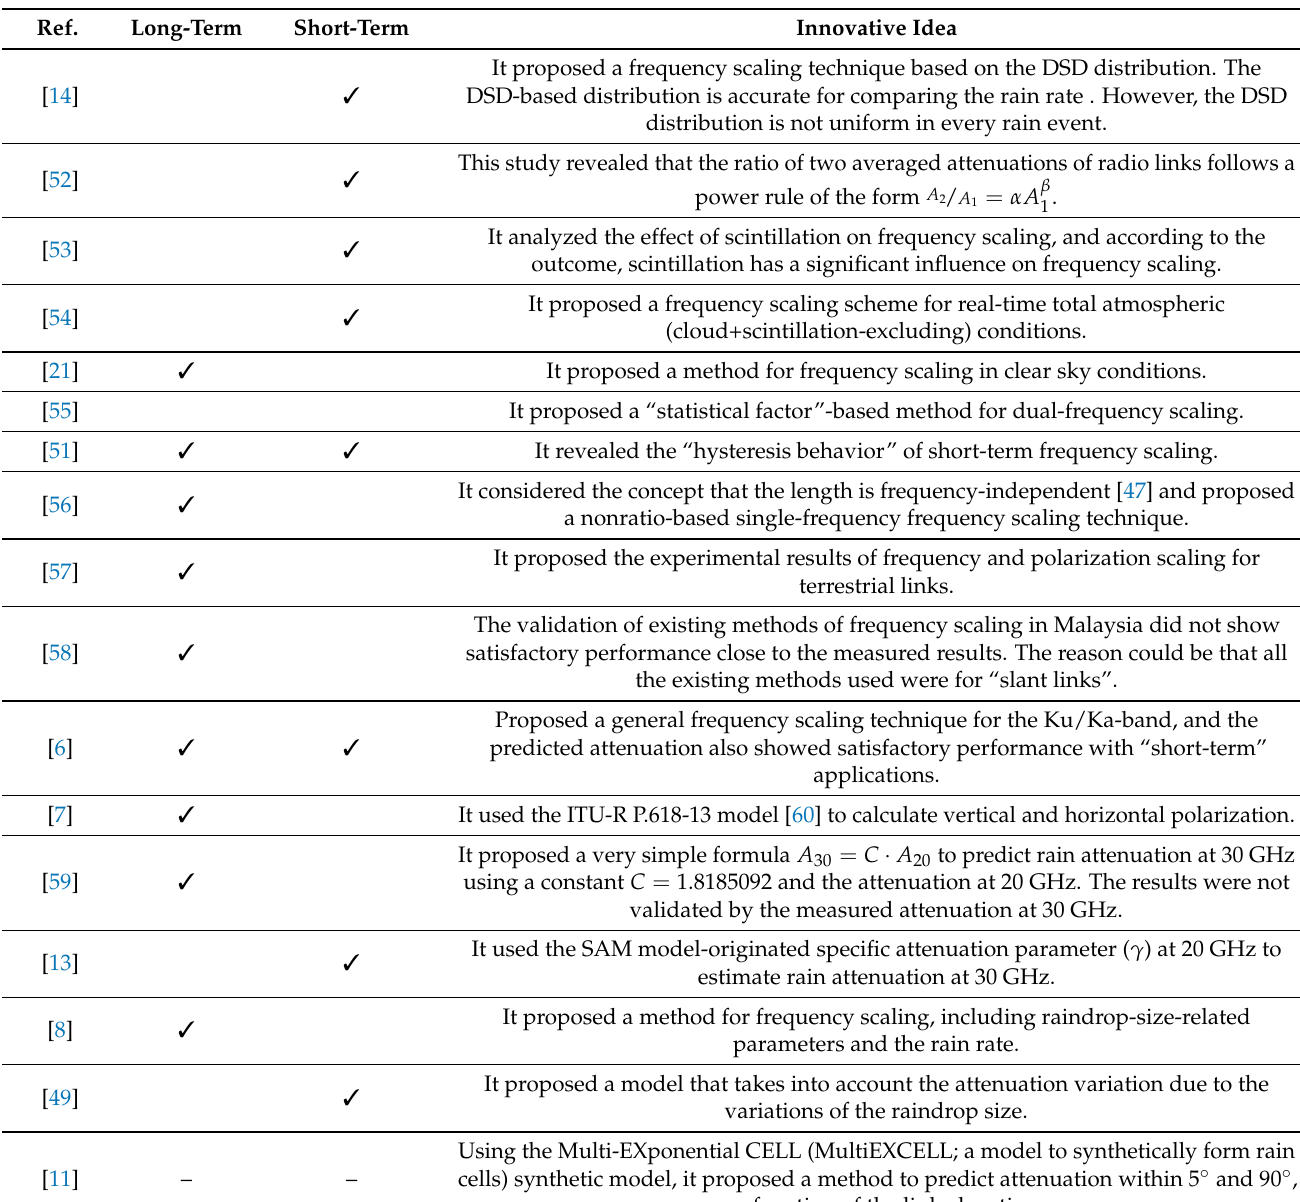
Table 2. Comparison among the scaling of propagation